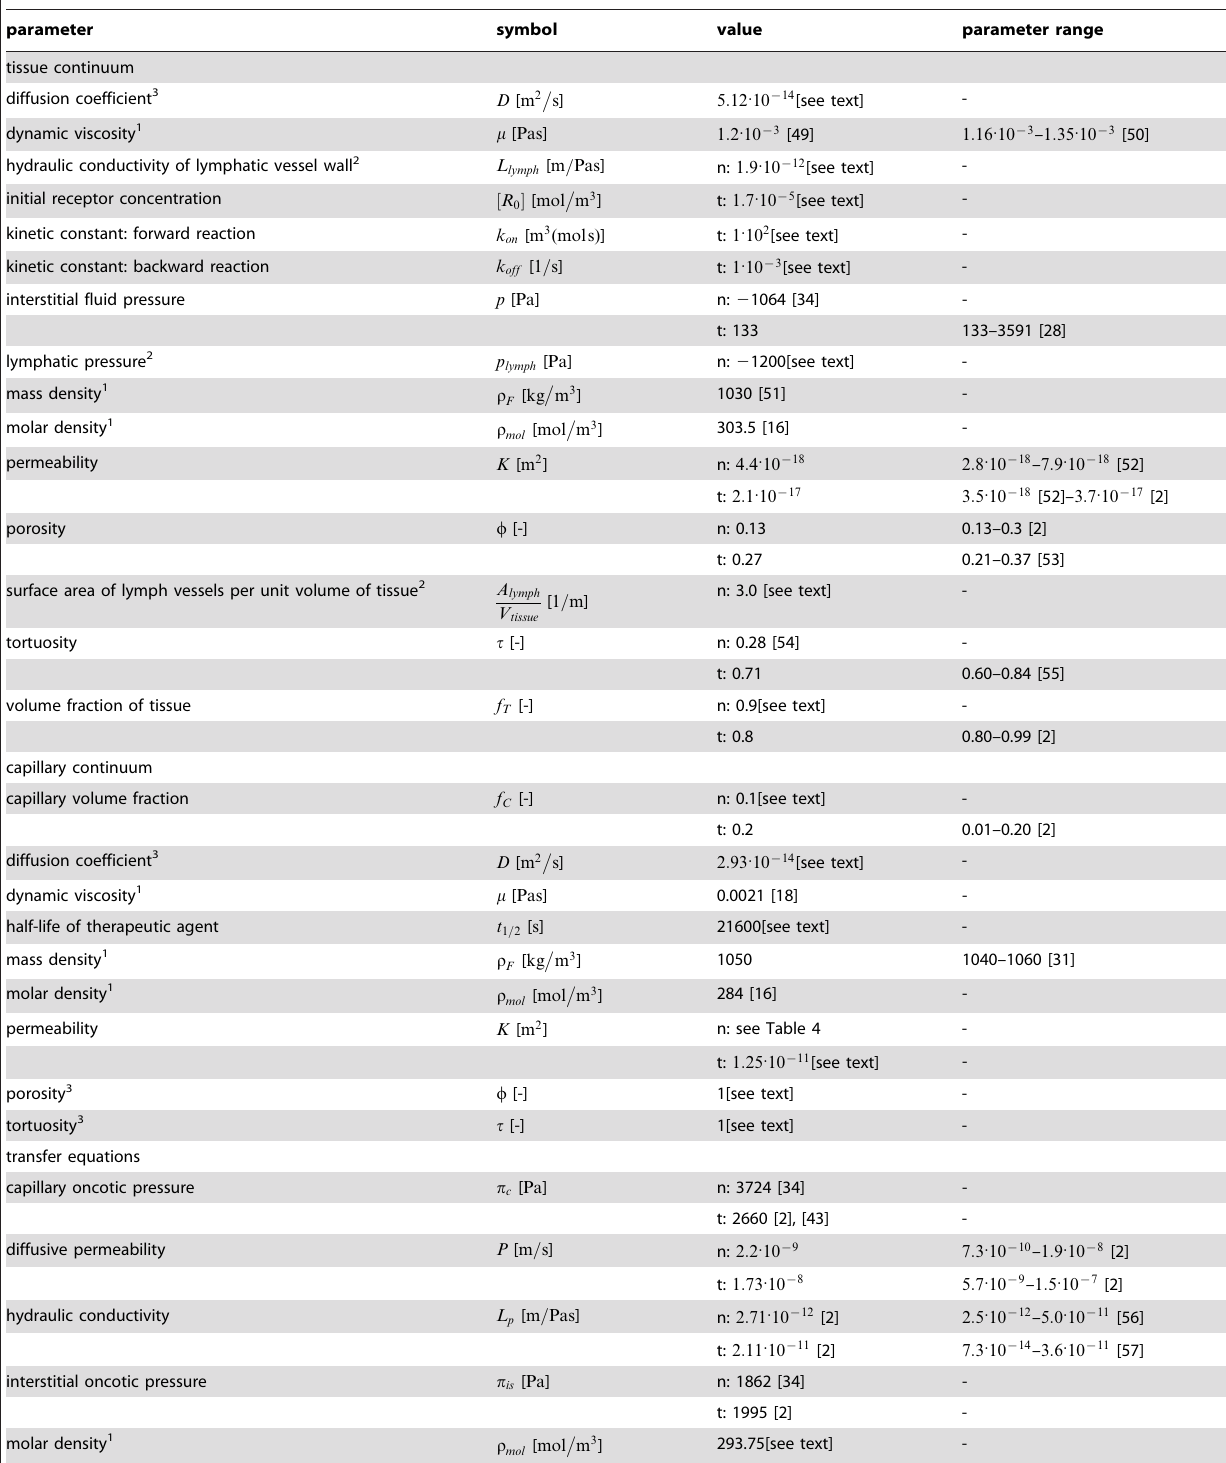
Table 3. Model parameters of the alveolus